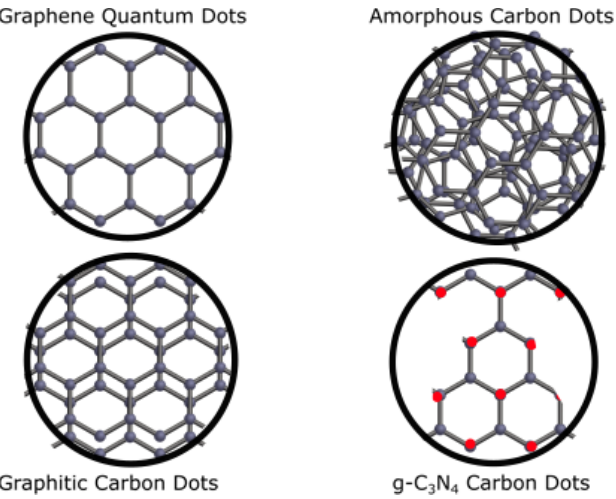
Figure 3. Schematic representation of commonly reported CD structures. Black and red dots represent Carbon and Nitrogen atoms,